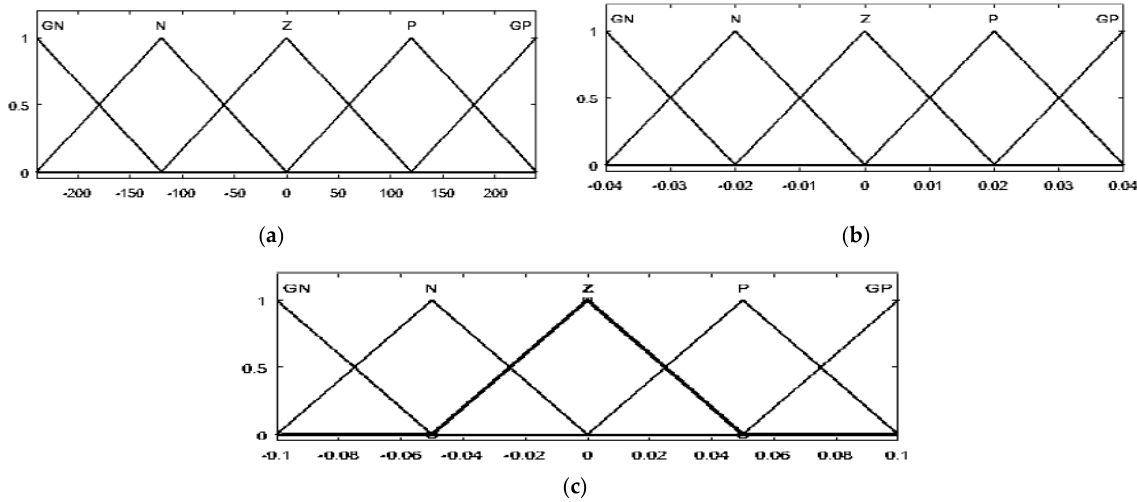
Figure 4. The membership function of E ( a ), dE ( b ), and duty cycle ( c ) for PVG.